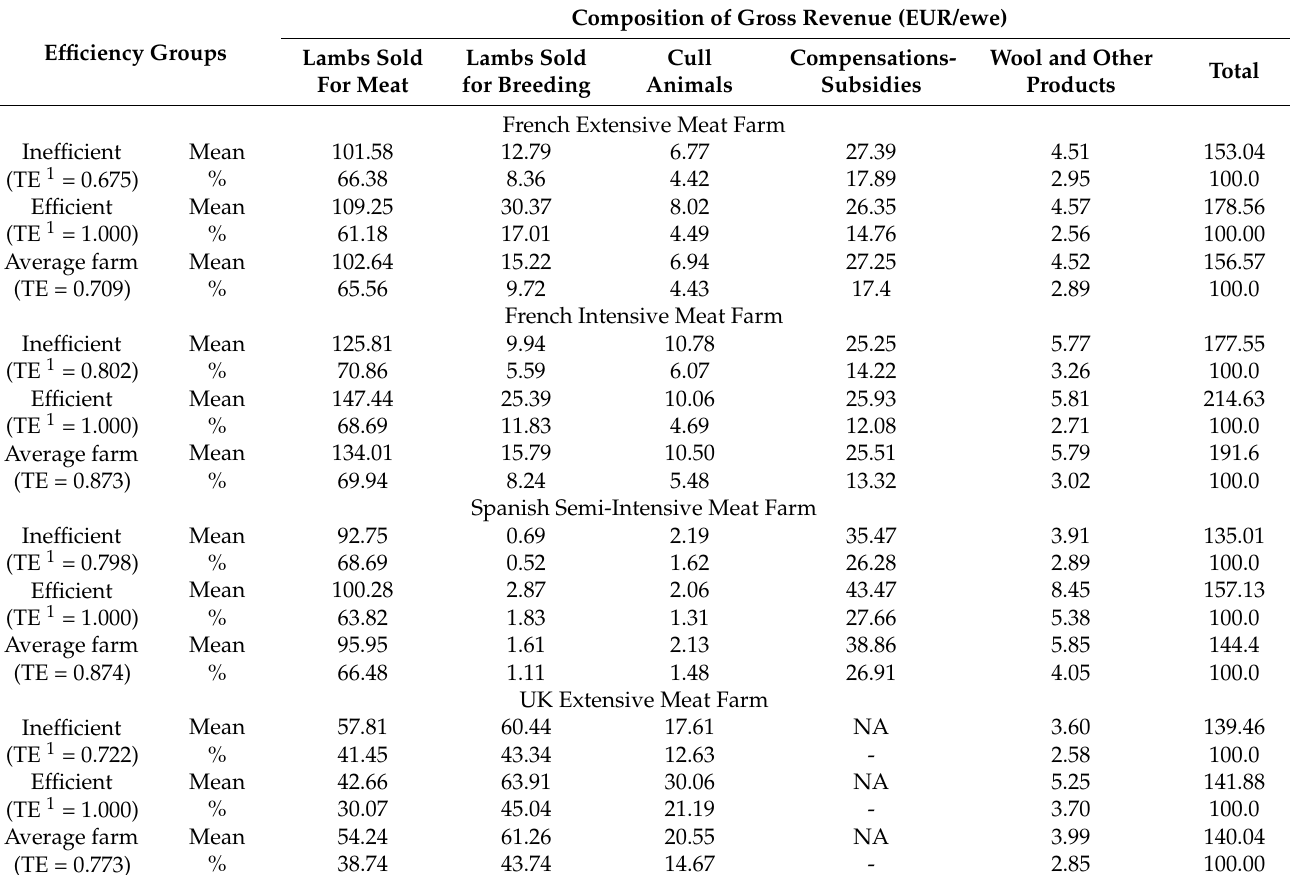
Table 3. Composition of gross revenue per ewe for the technical efficient and inefficient